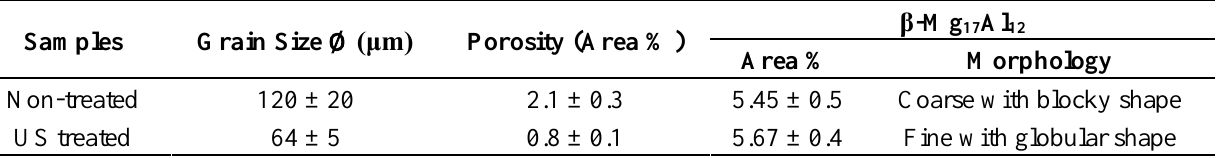
Table 2 . Characteristics of the